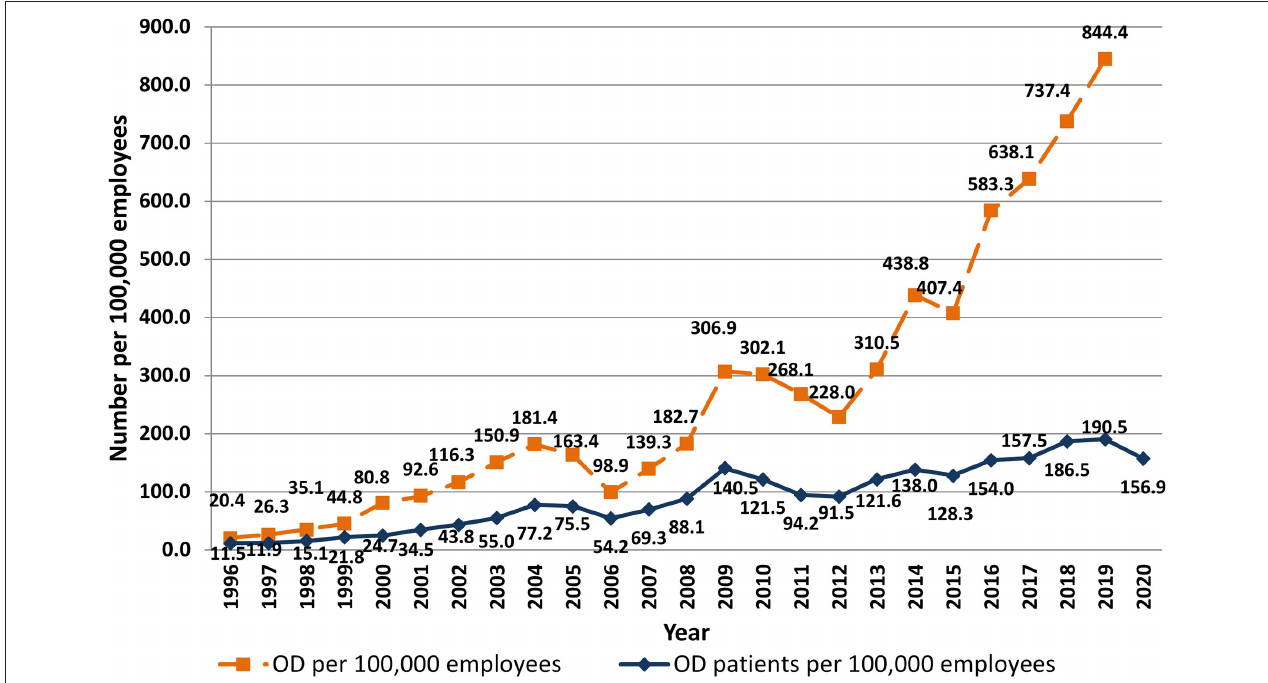
FIGURE 2 | Trends in first registered ODs in Latvia, 1996–2020 (number of patients and number of ODs per 100,000